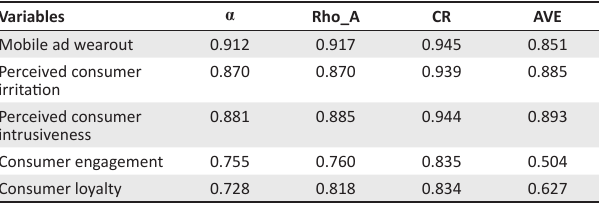
TABLE 2: Reliability and convergent validity.